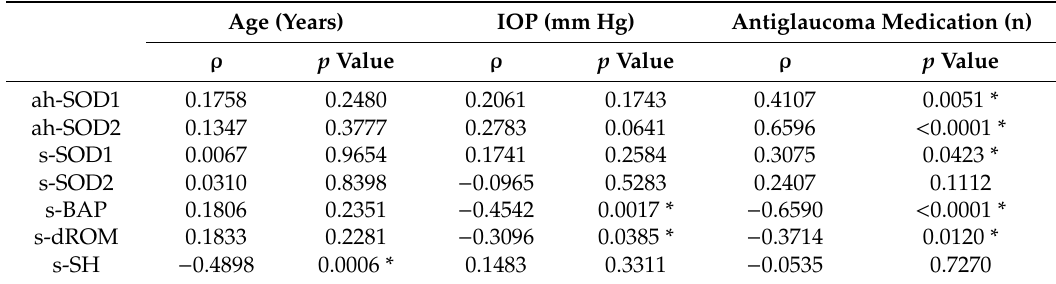
Table 4. Correlations among redox parameters and clinical